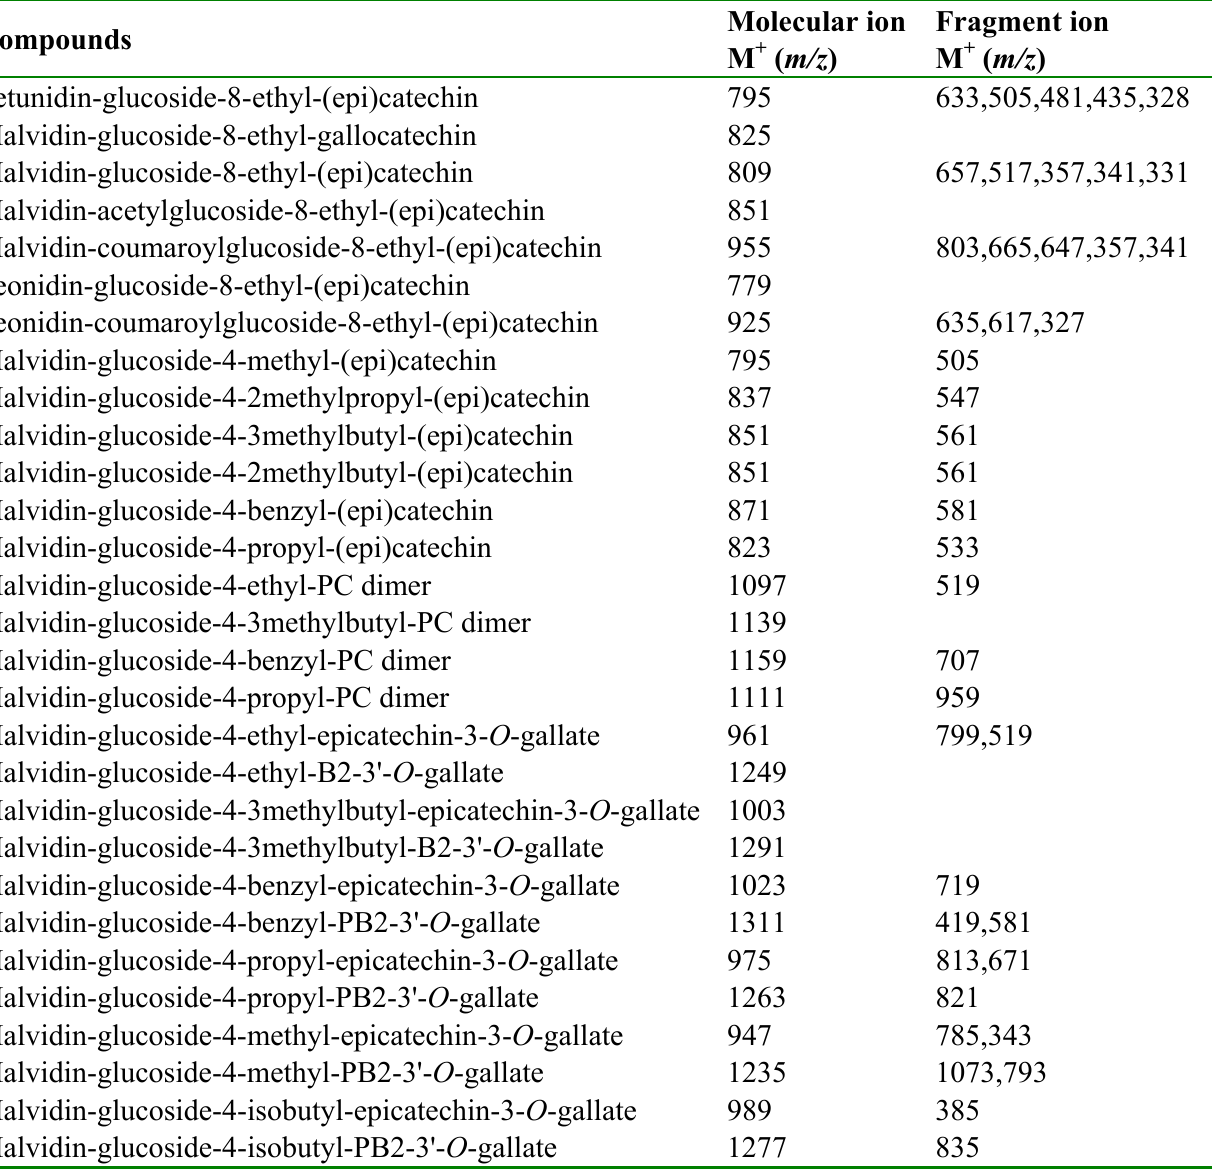
Table 3. The mass spectral data of some major products from aldehyde-mediated condensation reactions of anthocyanins and/or flavan-3-ols [63,64,66,128].